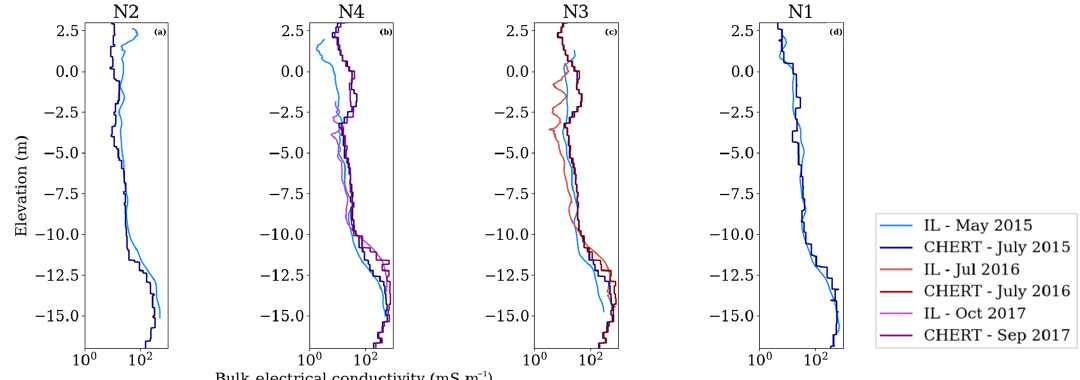
Figure 12. Comparison of bulk electrical conductivity models obtained from induction logs and CHERT along piezometers in nests N2 (a) , N4 (b) , N3 (c) and N1 (d) . The CHERT logs were extracted from the CHERT bulk EC models along the